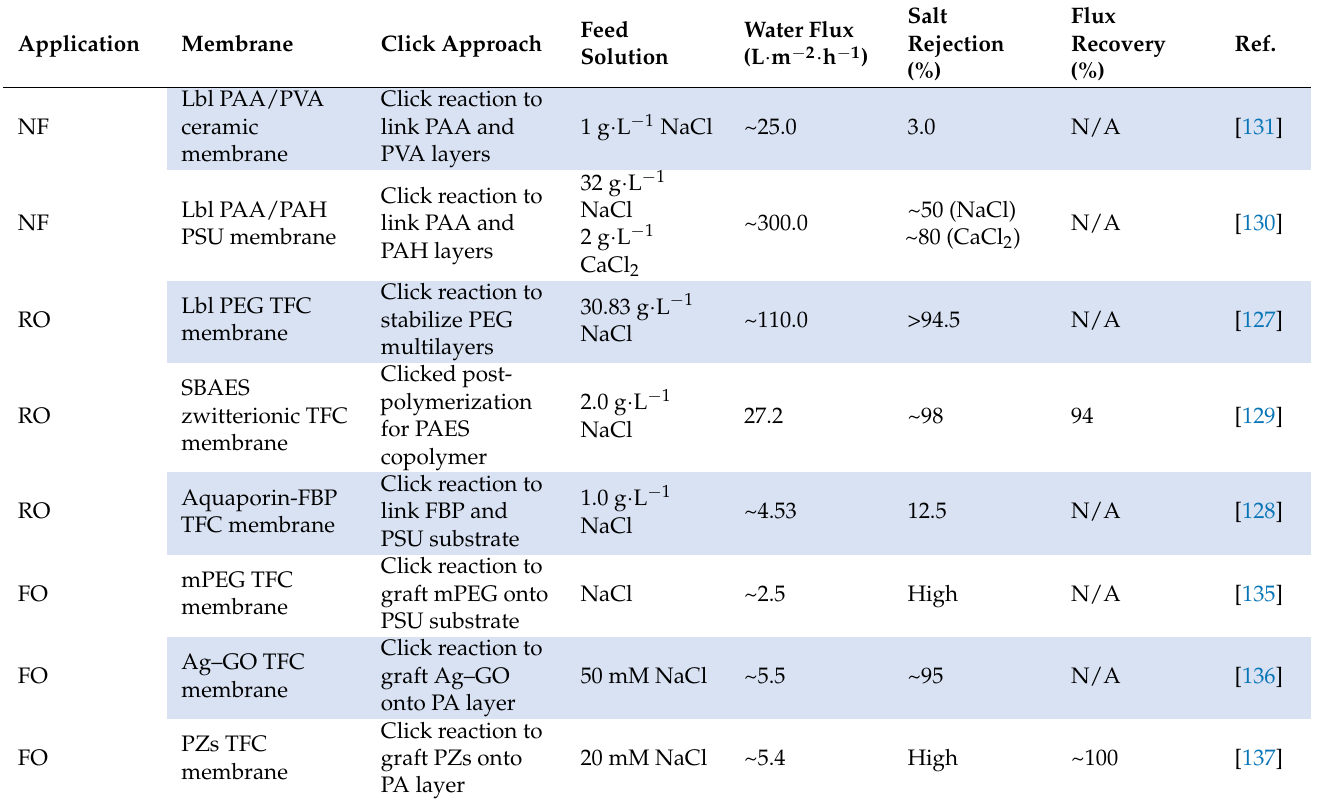
Table 6. Summary of click chemistry for membrane modification.